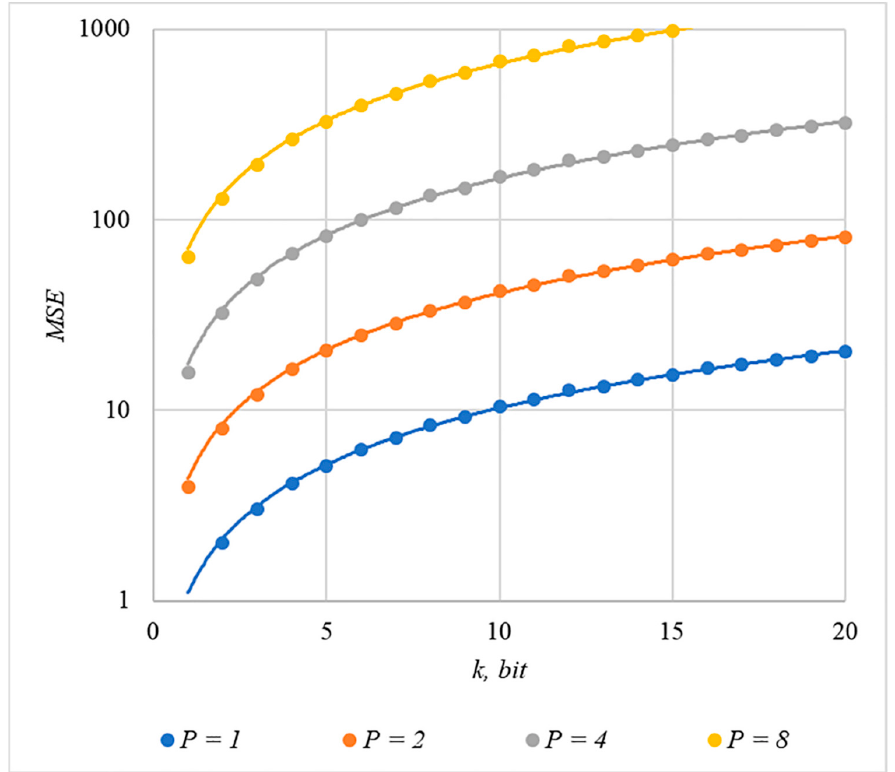
P rules for generating chip codes № 1, 3,